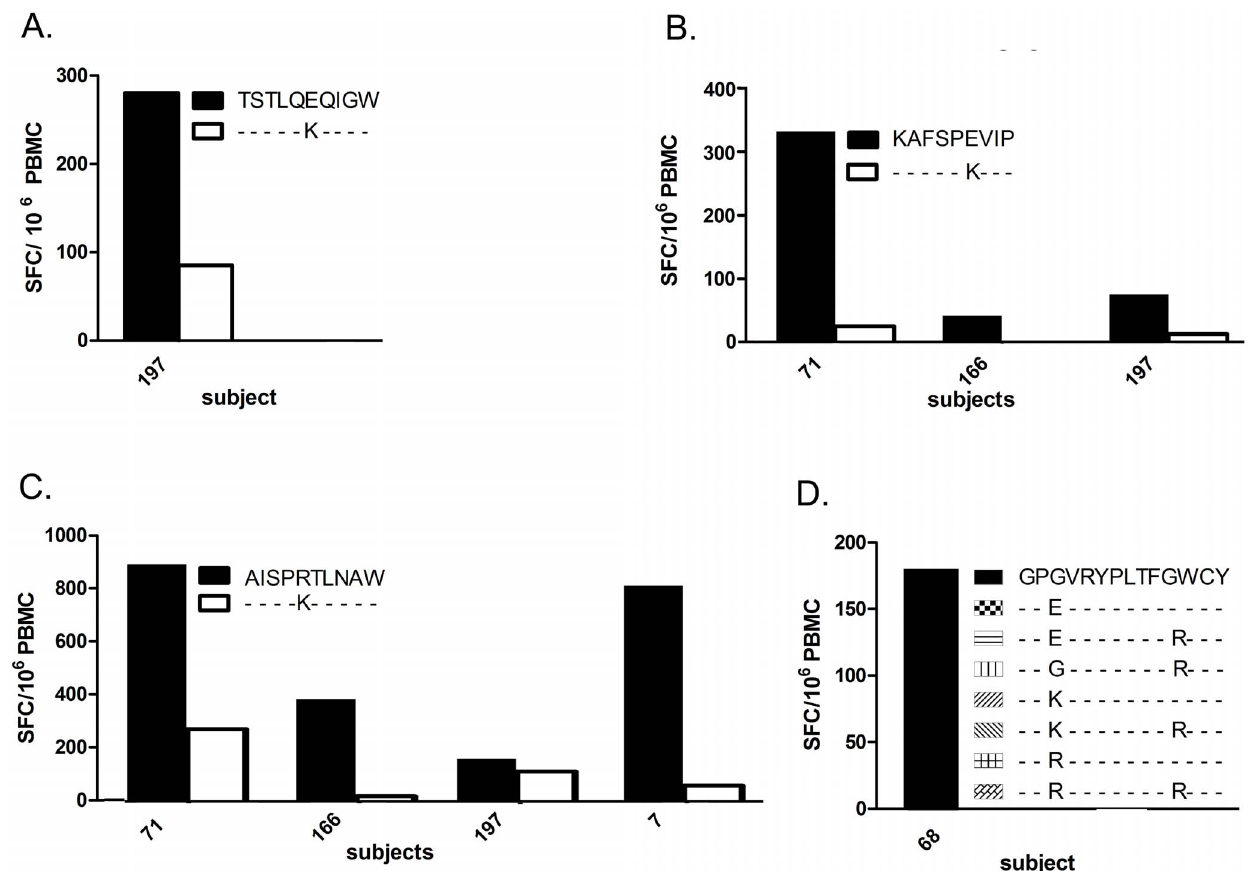
Figure 1. CD8 + T cell response to HLA-B57-restricted wild type and A3G/F-mutated epitopes. Responses of PBMC from HLA-matched subjects to wild type and mutant epitopes are shown on the Y-axis, as IFN- c SFC (Spot Forming Cells)/10 6 PBMC. A. Comparison of IFN- c induction between wild type and a mutant form of the B57-restriced Gag epitope TSTLQEQIGW. B. Comparison of IFN- c induction between wild type and 2 mutant forms of the B57-restriced Gag epitope KAFSPEVIP. C. Comparison of IFN- c induction between wild type and a mutant form of the B57- restriced Gag epitope AISPRTLNAW. D. Comparison of IFN- c induction between wild type and 7 mutant forms of the B57 restricted Nef epitope GPGVRYPLTFGWCY.